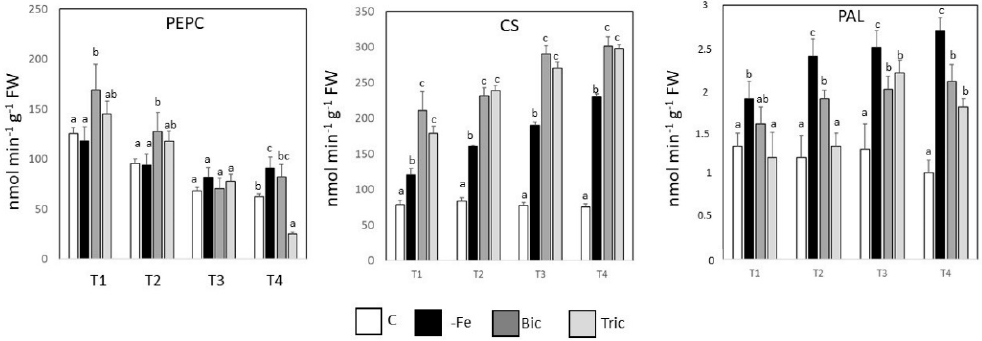
Figure 6. Enzymatic activity (phosphoenol pyruvate carboxylase - PEPCase, citrate synthase -CS, and phenylalanine ammonia lyase -PAL).) in the roots of plants grown in control conditions (C), direct iron deficiency conditions (–Fe), and under induced Fe deficiency in the presence of bicarbonate (Bic) or alkaline organic bu ff er (Tric). T1, T2, T3, and T4 correspond to sampling at 1, 3, 5, and 7 days. Data are expressed as the means ± SE ( n = 5). Enzyme activity is expressed as nmol min − 1 mg − 1 prot. Significant di ff erences are labelled with di ff erent letters ( p < 0.05) within each